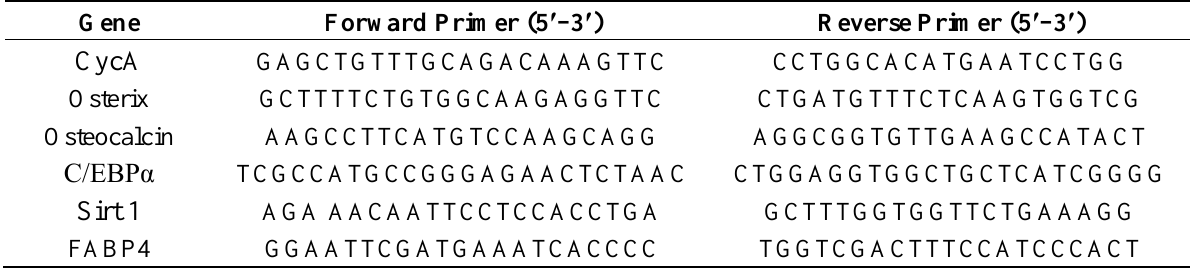
Table 1. Forward and reverse primer sequences used in the polymerase chain reaction (PCR) study. Gene Forward Primer (5′–3′)